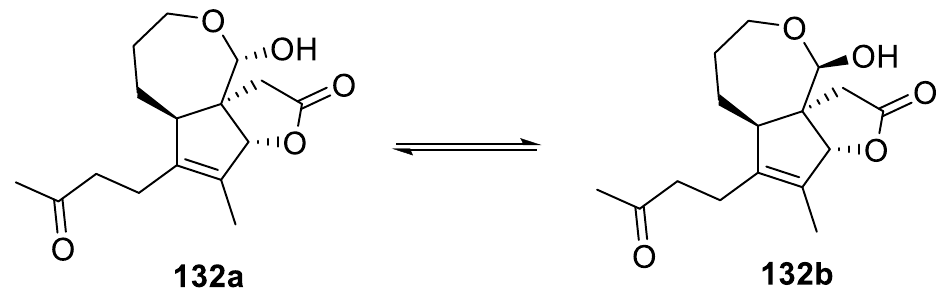
Figure 64. Structure of [4.6.0] spirocyclic seconoriridone A.